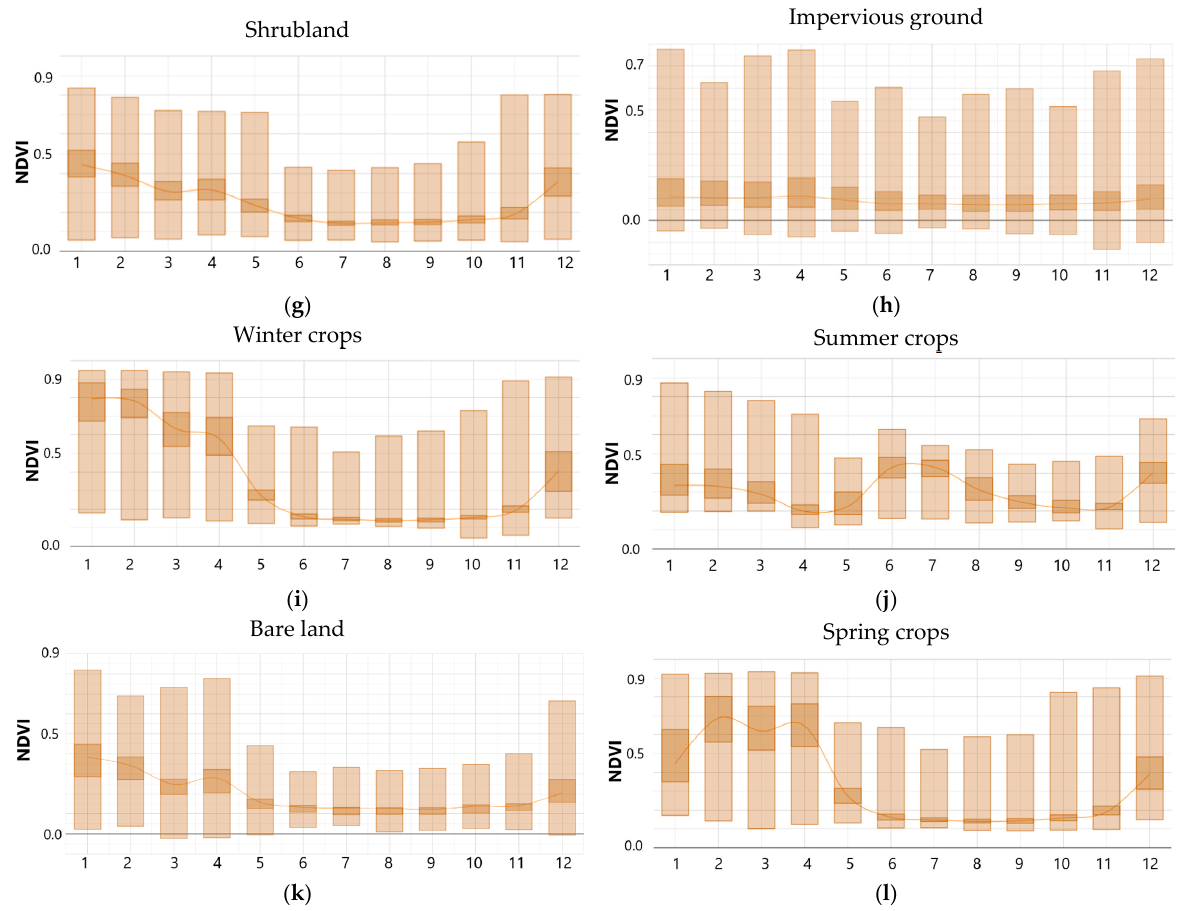
Figure 7. Monthly NDVI 1st, 2nd, and 3rd quartiles from collected training data of perennial and non-perennial land use classes. Based on Copernicus Sentinel-2 data (2020).